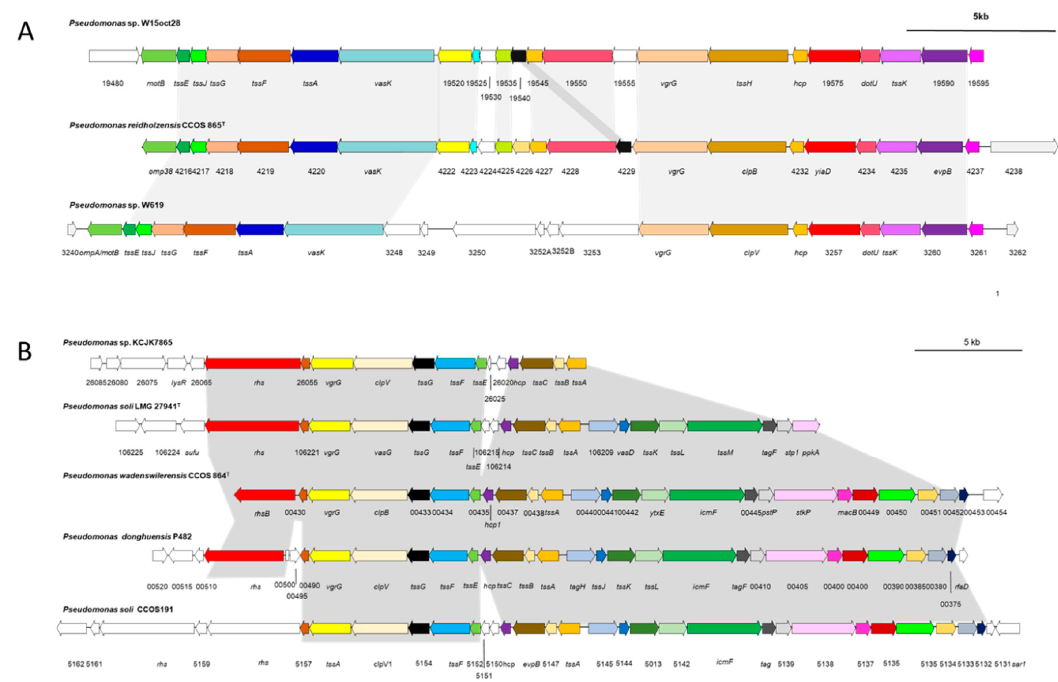
Figure 6. Type VI secretion systems. ( A ): The type VI secretion cluster (T6SS) of Pseudomonas reidholzensis CCOS 865 T and related sequences in other strains. Genes aligning to each other are marked in the same color, while the grey background marks identical alignments of the genes within the cluster. ( B ): The type VI secretion cluster (T6SS) of Pseudomonas wadenswilerensis CCOS 864 T and related systems in other Pseudomonas strains. Identical genes are marked in the same color, while the grey shading indicates the same gene arrangement.